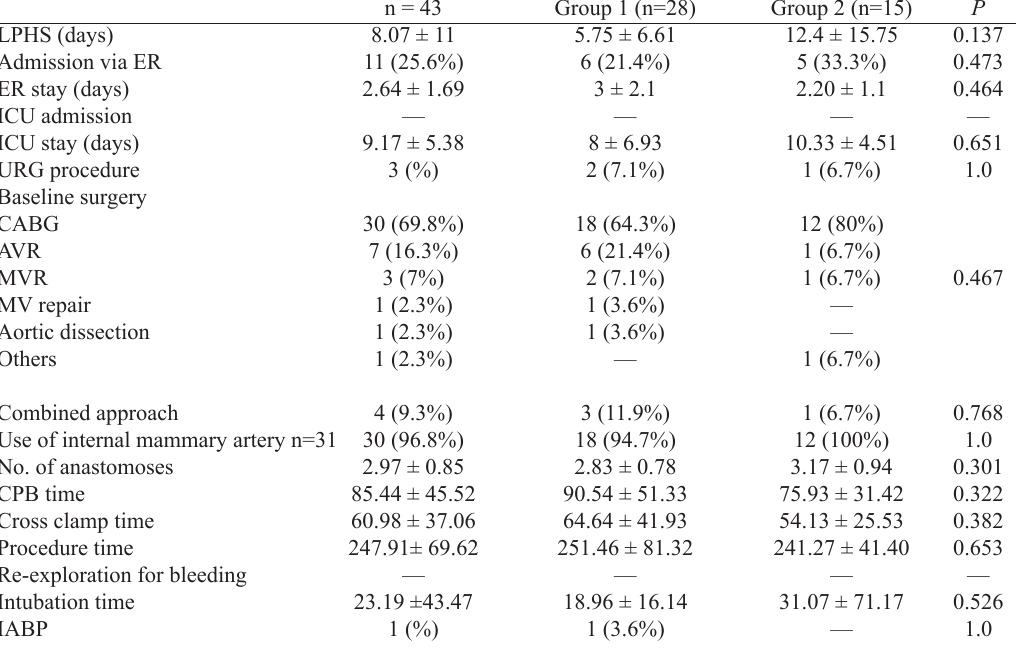
Table 2. First procedure.